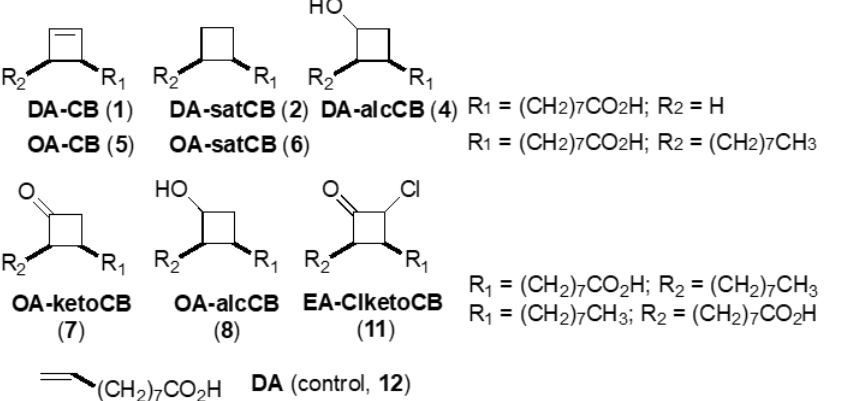
Figure 1. Structures of fatty acid derivatives investigated in this study and the decenoic acid control (DA, 12).